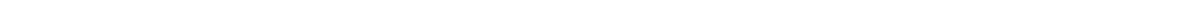
Fig. 6 Notch is a target of tankyrase. a Schematic diagram of Notch1/2. Shaded box; RAM (RPBJ association molecule) domain that binds RPBJ (recombining binding protein suppressor of hairless). PM plasma membrane. Alignment of tankyrase-binding sites; identical amino acids in black. The acidic residue at the 8th position of the tankyrase-binding motif indicates an 8-amino-acid motif. b Immunoblot analysis showing Notch2 is stabilized in RNF146 siRNA-treated HEK293T cells. c Endogenous tankyrase and Flag-Notch2 coimmunoprecipitate. Immunoblot analysis of HEK293T cells transfected with Flag-Notch2 and immunoprecipitated with tankyrase IgG. d Endogenous tankyrase and Flag-Notch2 coimmunoprecipitate, dependent on the Notch2 tankyrase-binding site. Immunoblot analysis of HEK293T cells transfected with vector, Flag-Notch2 WT, or Flag-Notch2 Mut and immunoprecipitated with anti-tankyrase IgG. e Notch2 is a target for ADP-ribosylation by tankyrase 1. Flag-Notch2 or Myc-TRF1 immunoprecipitates from HEK293T cells were incubated with 32 P-NAD + and recombinant tankyrase 1, fractionated by SDS-PAGE and visualized by Coomassie blue (left panel; asterisks indicate FlagNotch2 and MycTRF1) and autoradiography (right panel). f Notch2 is increased at the plasma membrane in TNKS DKO cells. Immuno fl uorescence analysis of formaldehyde- fi xed HEK293T WT, TNKS DKO, or TNKS DKO expressing tankyrase 1 and 2 (T1T2) cells stained with anti-Notch2 antibodies (green). DNA was stained with DAPI (blue). Scale bar, 5 μ m. g Notch2 is increased at the plasma membrane in HeLa cells treated with inhibitors to tankyrase (Ti8) or γ -secretase (DAPT). Immuno fl uorescence analysis was performed as described in f . h , i Expression of the Notch target gene Nestin is reduced in h TNKS DKO cells and in i inhibitor-treated HEK293T cells. mRNA levels were quanti fi ed using qRT-PCR. Average of two to four independent experiments (with three technical replicates each) ± SD. * p ≤ 0.05, ** p ≤ 0.01, Student's unpaired t -test. j – l Notch2 stability is regulated by TNKS1, not TNKS2. j Immuno fl uorescence analysis of TNKS1 and TNKS2 DKO cells was performed as in f . k Immunoblot analysis of HEK293T WT and TNKS KO cells lines. l graphical representation of the abundance in TNKS KO cells relative to WT. Average of two independent experiments ± SEM. * p ≤ 0.05, Student's unpaired t